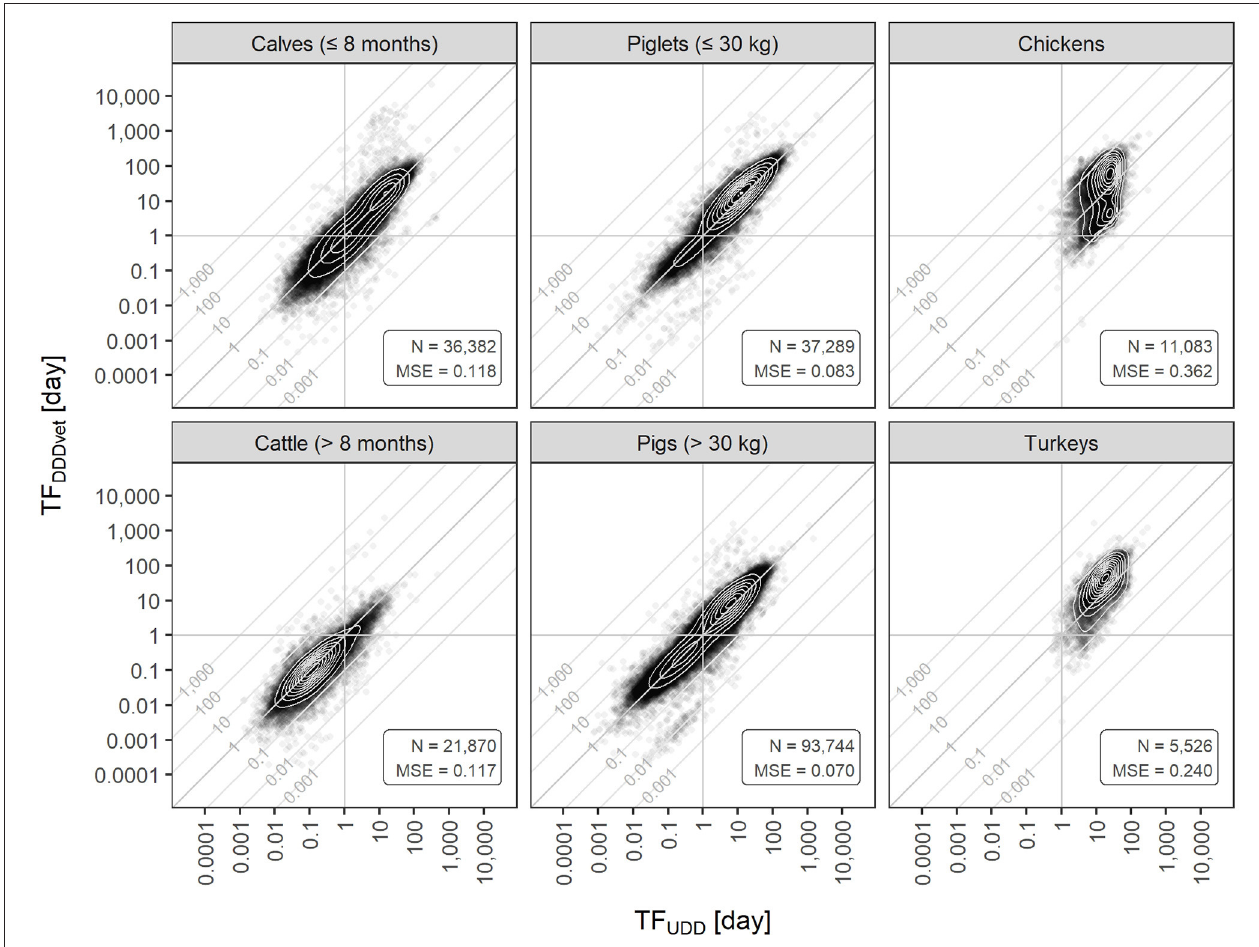
FIGURE 2 | Farm-level DDDvet-based treatment frequencies (TF DDDvet ) vs. UDD-based treatment frequencies (TF UDD ) for each of the six animal populations covered by the German benchmarking system. Both axes are log-scaled. Diagonal lines depict isoclines along which the average animal daily dose ratio ( ADDR) has the same value. Contour lines show the two-dimensional density. Data is from all half-year periods 2014-2 to 2017-2. N, number of farms; MSE, mean squared error with respect to the main diagonal where ADDR =